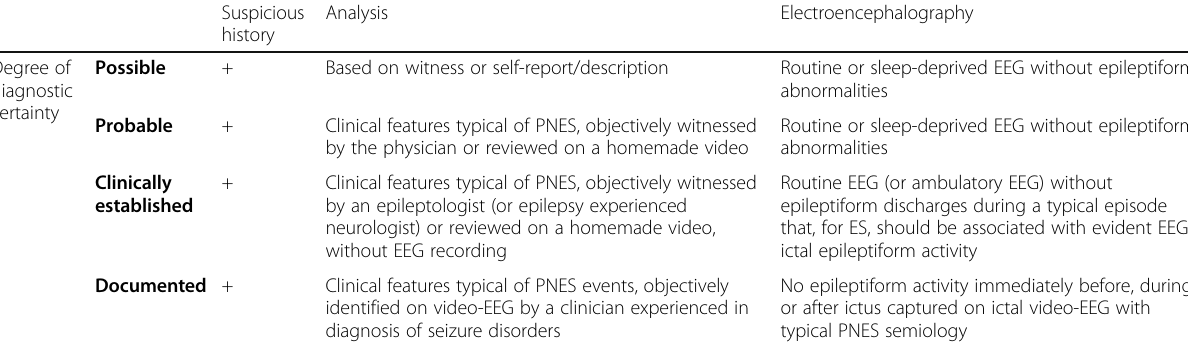
Table 4 Table of PNES diagnosis certainties, adapted from the work by LaFrance et al. (2013) for the ILAE Nonepileptic Seizures Task Force (with permission)